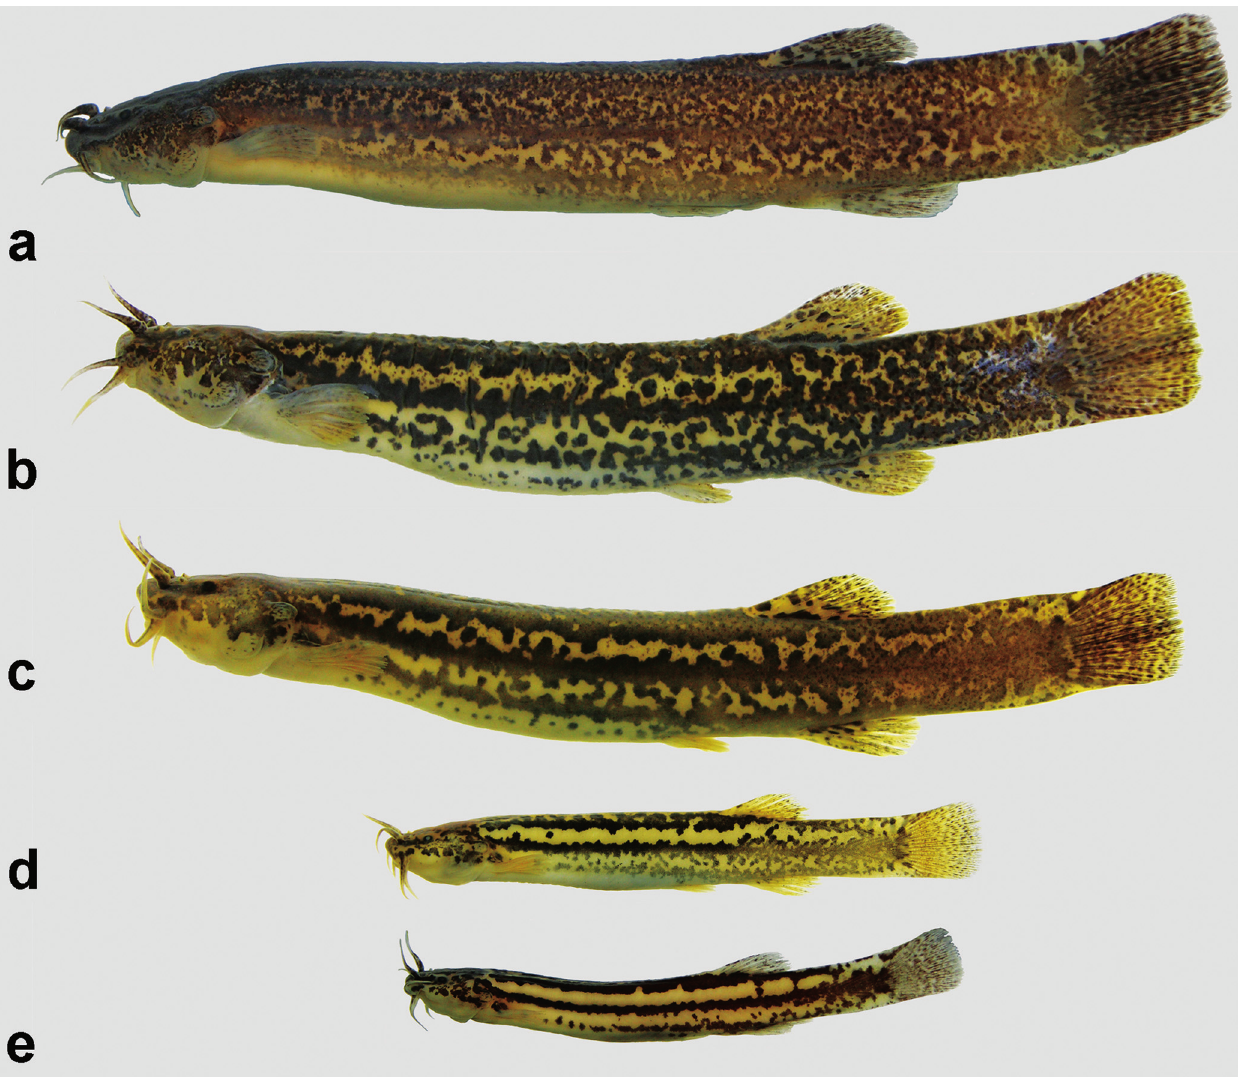
Fig. 14. Paratypes of Trichomycterus poikilos (UFRGS 14992, 40.5-92.5 mm SL) with ontogenetic variation in coloration. Specimens represented in